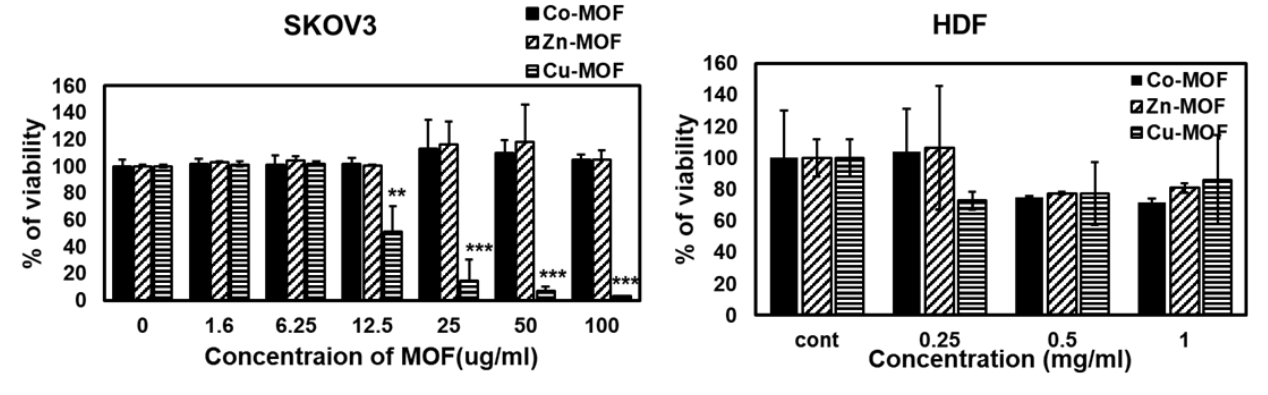
Figure 7. In vitro anticancer activity and cytotoxicity of MOFs in human ovarian cancer SKOV3 cells and human dermal fibroblast (HDF) cells. Cell viability in each sample was detected using alamar blue dye following incubation with a MOF for 24 h. All values are presented as means ± SD of three independent experiments. ** p < 0.01, and *** p < 0.001.